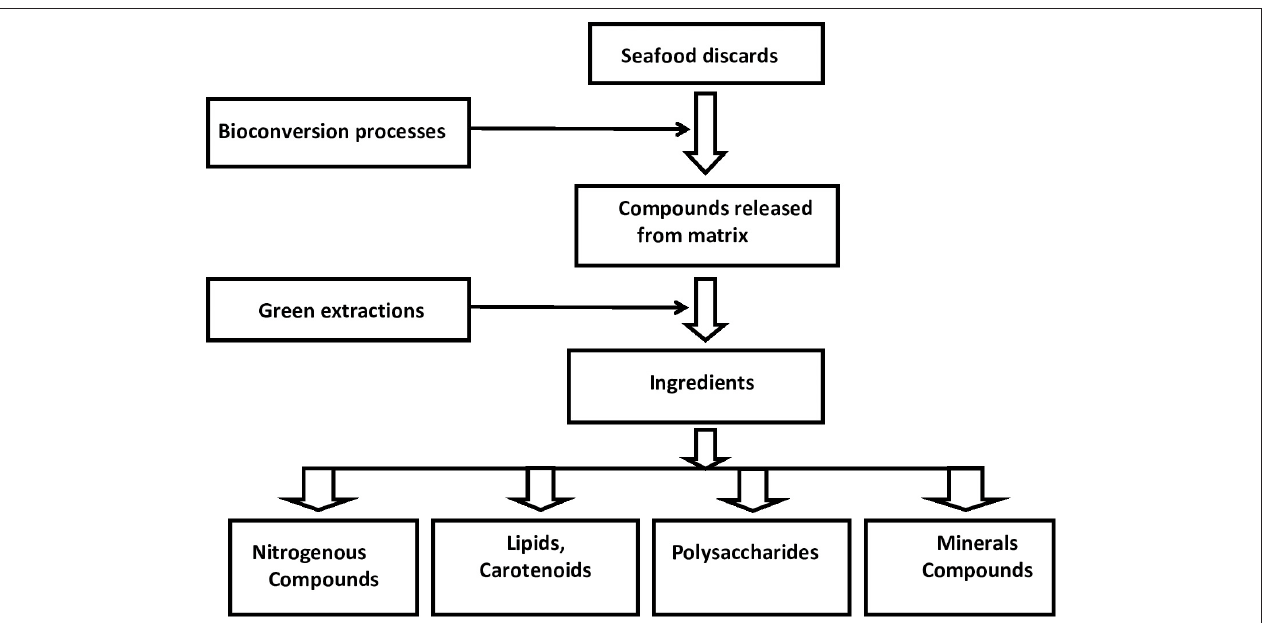
FIGURE 1 | Schematic representation of bioconversion for valorization of seafood discards and the major classes of compounds that can be extracted from seafood processing discards.